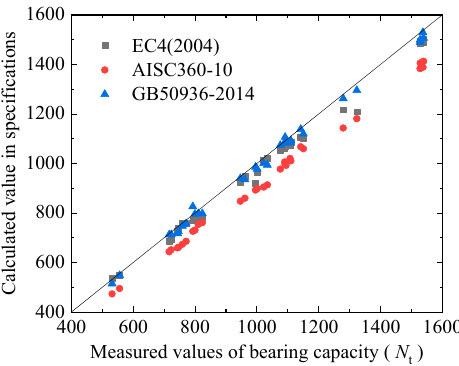
Figure 9. Comparison of measured values of bearing capacity and values calculated by various specifications. Table 5. Percentage error analysis between calculated values and test values. Sample